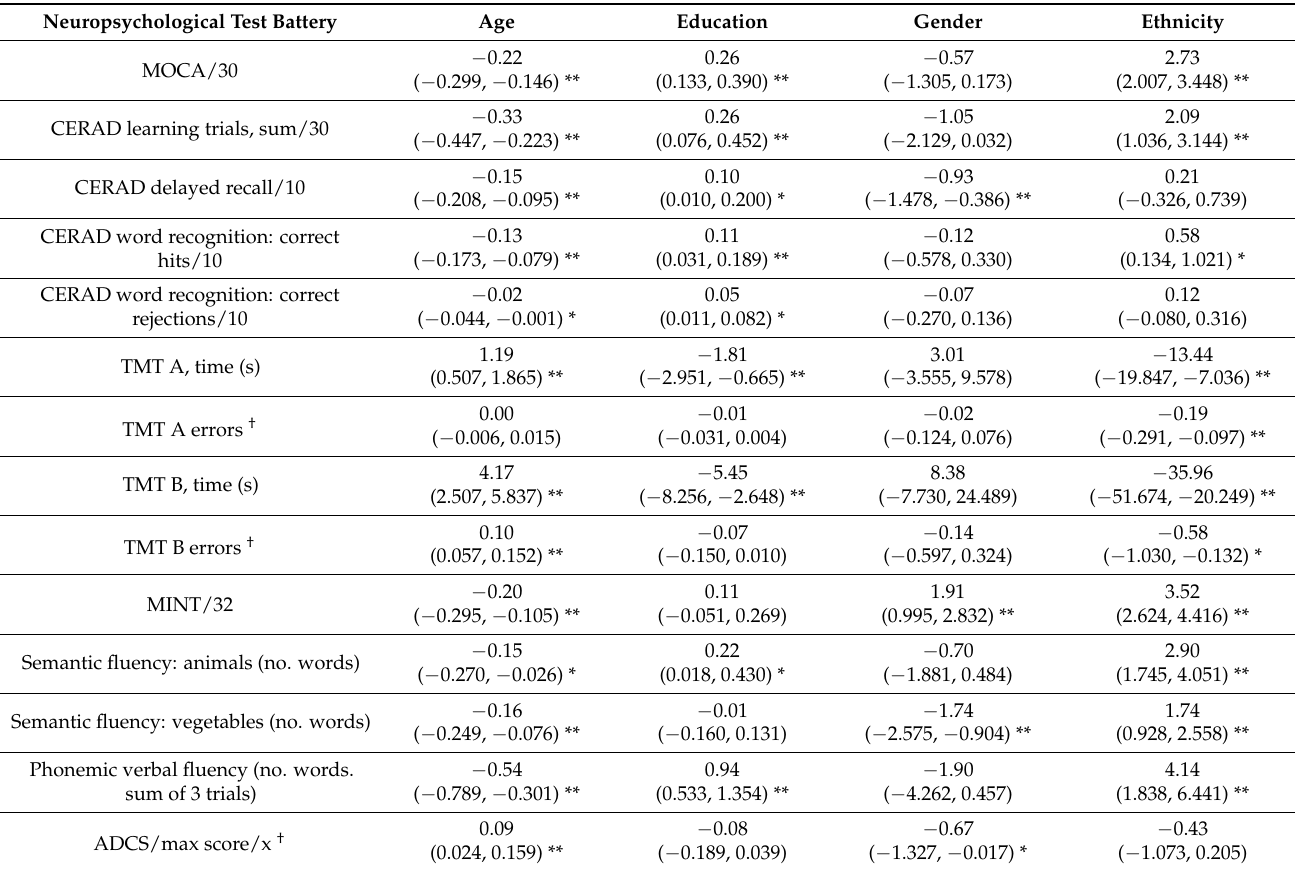
Table 7. Multiple regression models for neuropsychological test